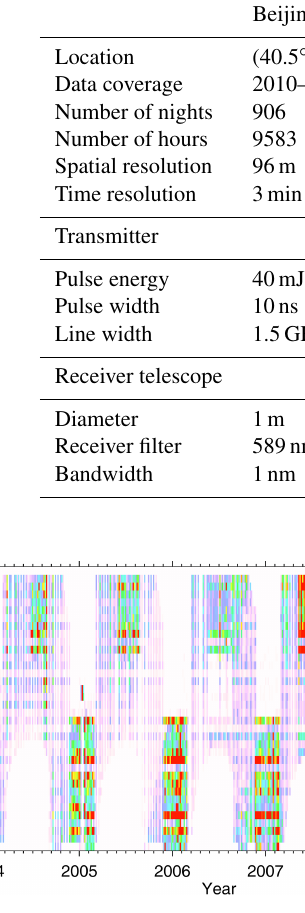
Figure 2. Time–latitude distribution of the number of the OSIRIS limb-scanning radiance measurements made by the Odin satellite during the period 2004 to 2009, with a resolution of a 5d × 5 ◦ lati- tude